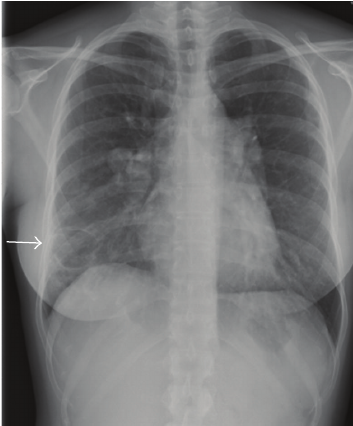
Figure 3: Follow-up chest X-ray shows a thin-walled cavitary lesion in the right lower lobe (white arrow).